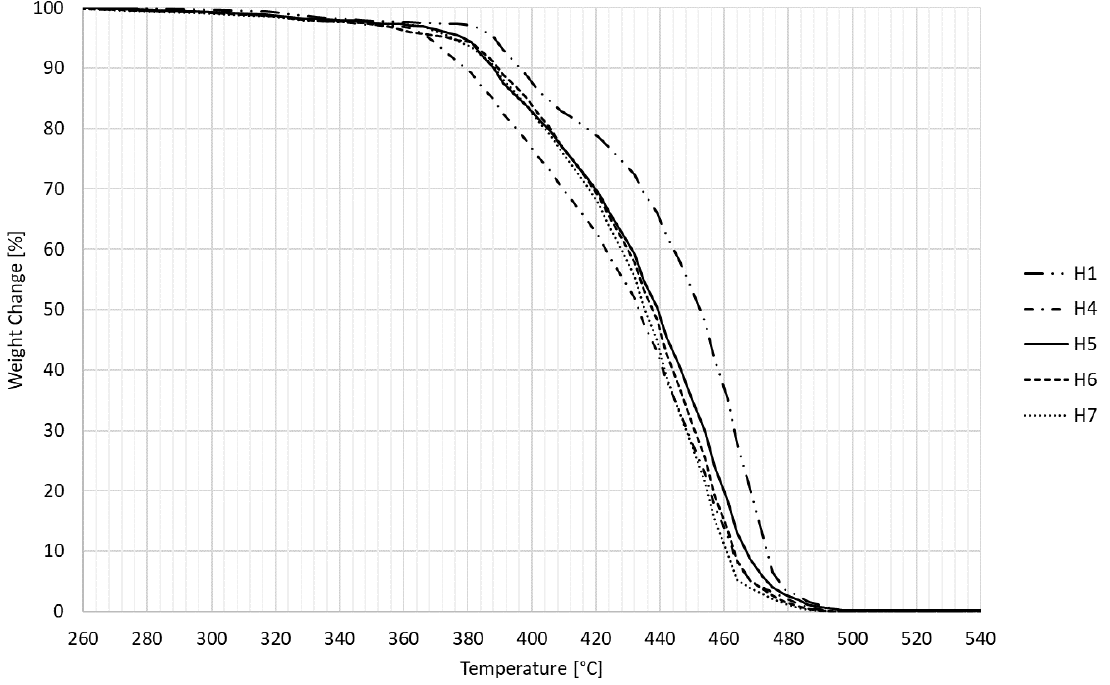
Figure 11. Degradation curves of nonmodified and modified HDPE specimens.